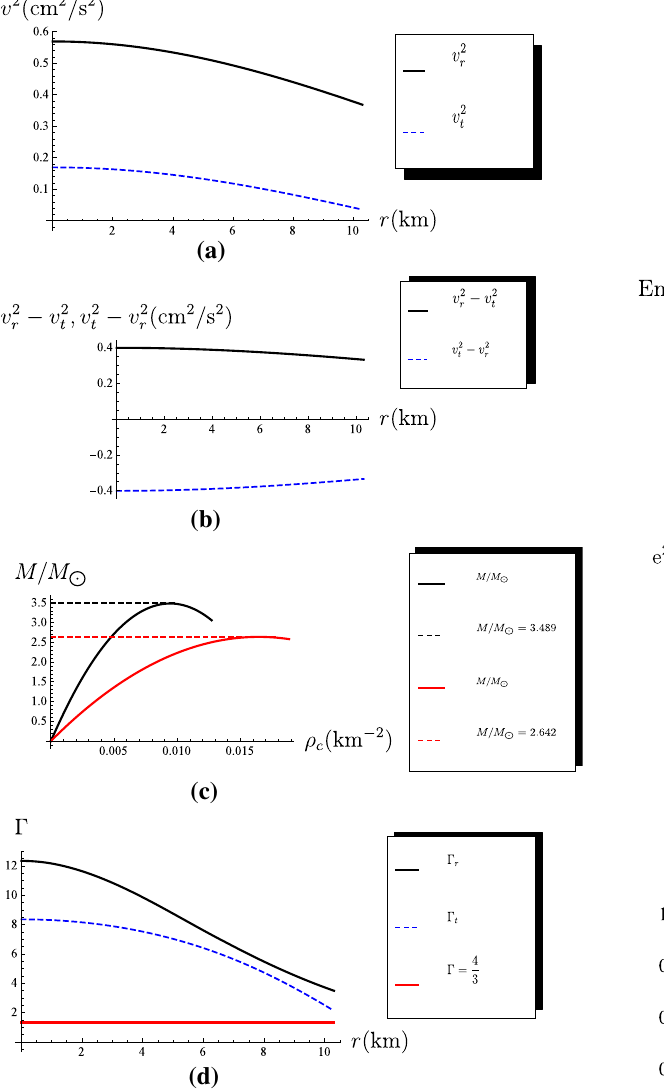
Fig. 2 Figures for PSRJ1614-2230